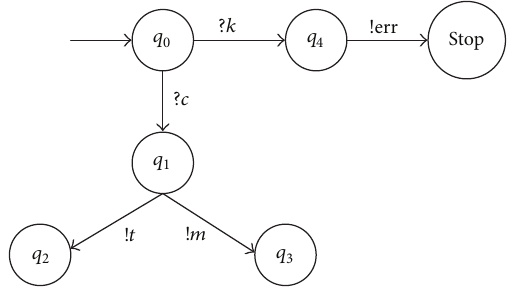
Figure 5: The improved IOLTS models for the AVM software.